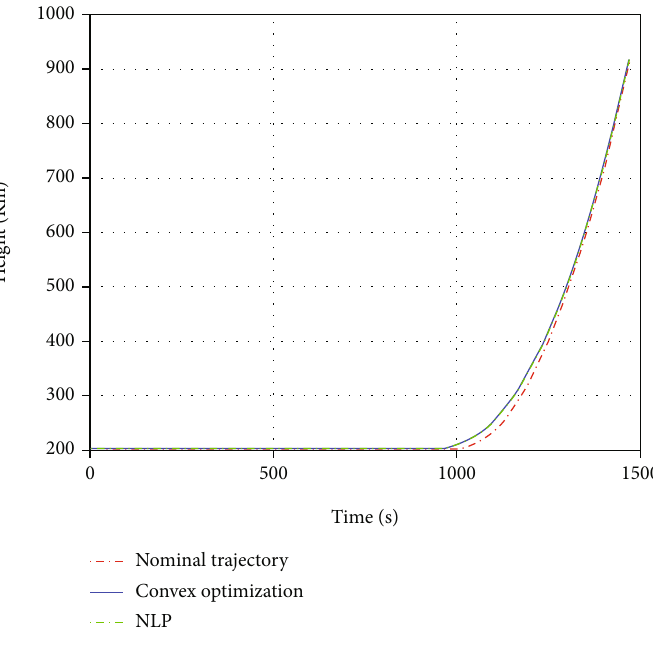
Figure 4: Curve of